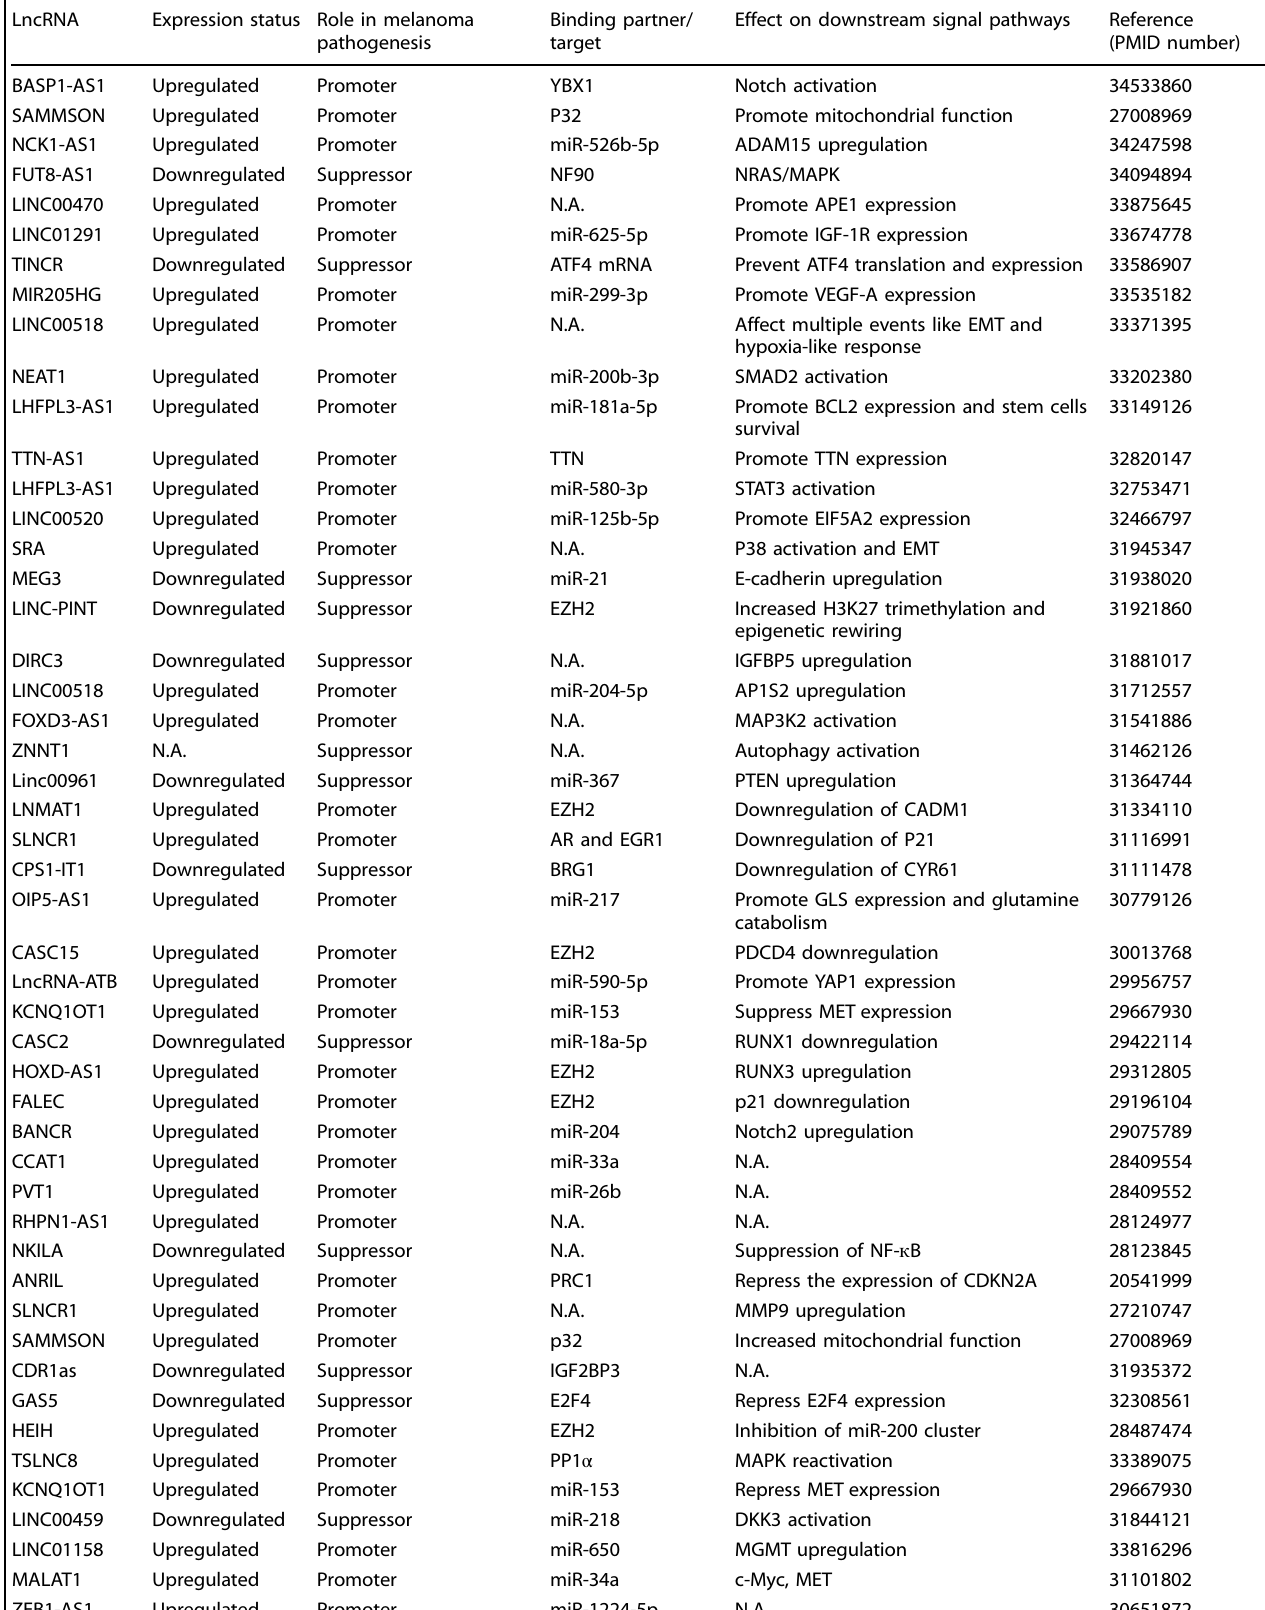
Table 2. Current progress of lncRNAs in melanoma pathogenesis LncRNA Expression status Role in melanoma